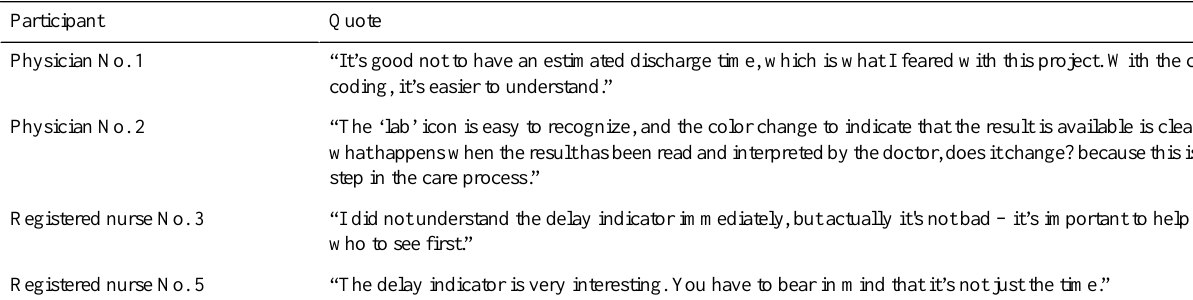
Table 1. Quotes from registered nurses and physicians during phase 1 of the user